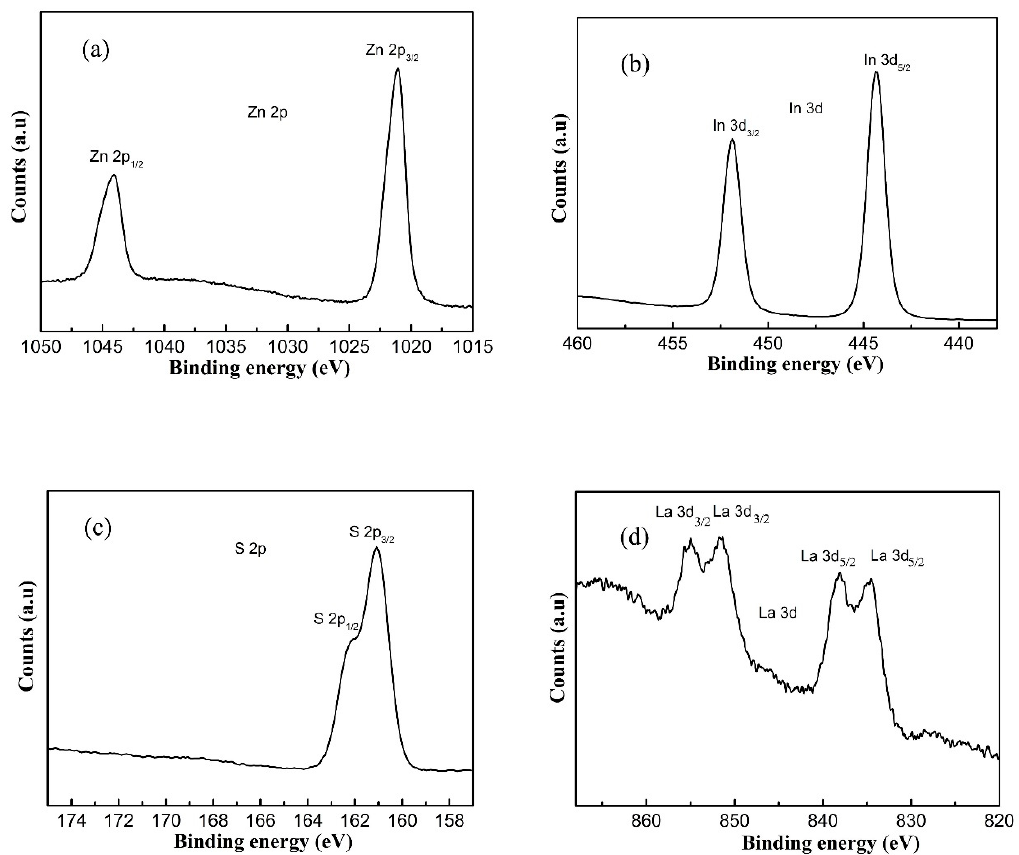
Figure 3. High resolution X–ray photoelectron spectroscopy (XPS) spectra of 1.5L-ZIS sample: ( a ) Zn 2p; ( b ) In 3d; ( c ) S 2p; ( d ) La 3d.